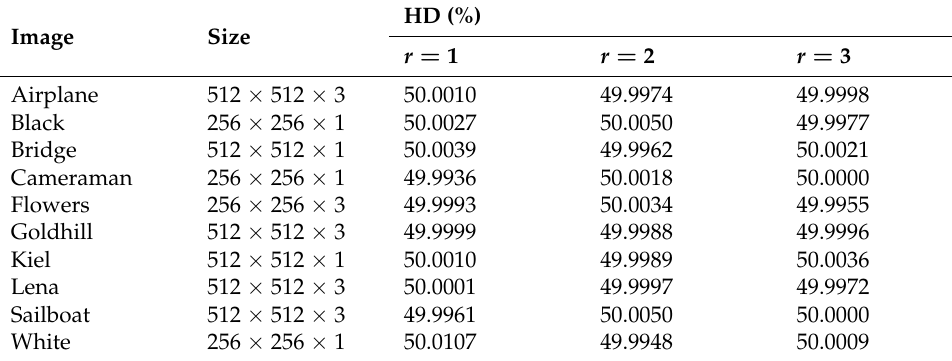
Table 3. HD versus the round times in the encryption